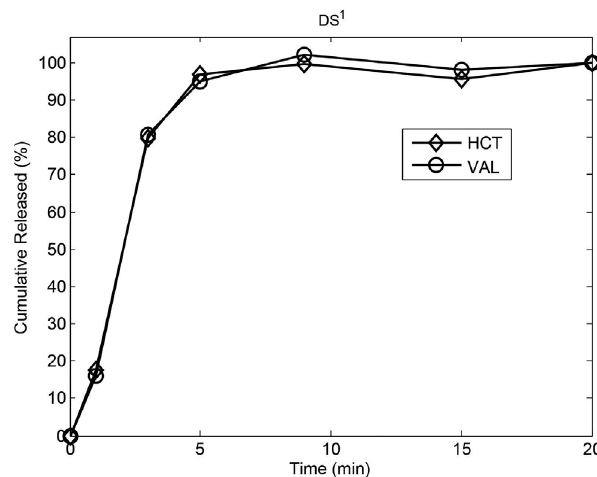
FIGURE 7B - Dissolution profiles of VAL and HCT obtained by applying RS-mexh-CWT method.